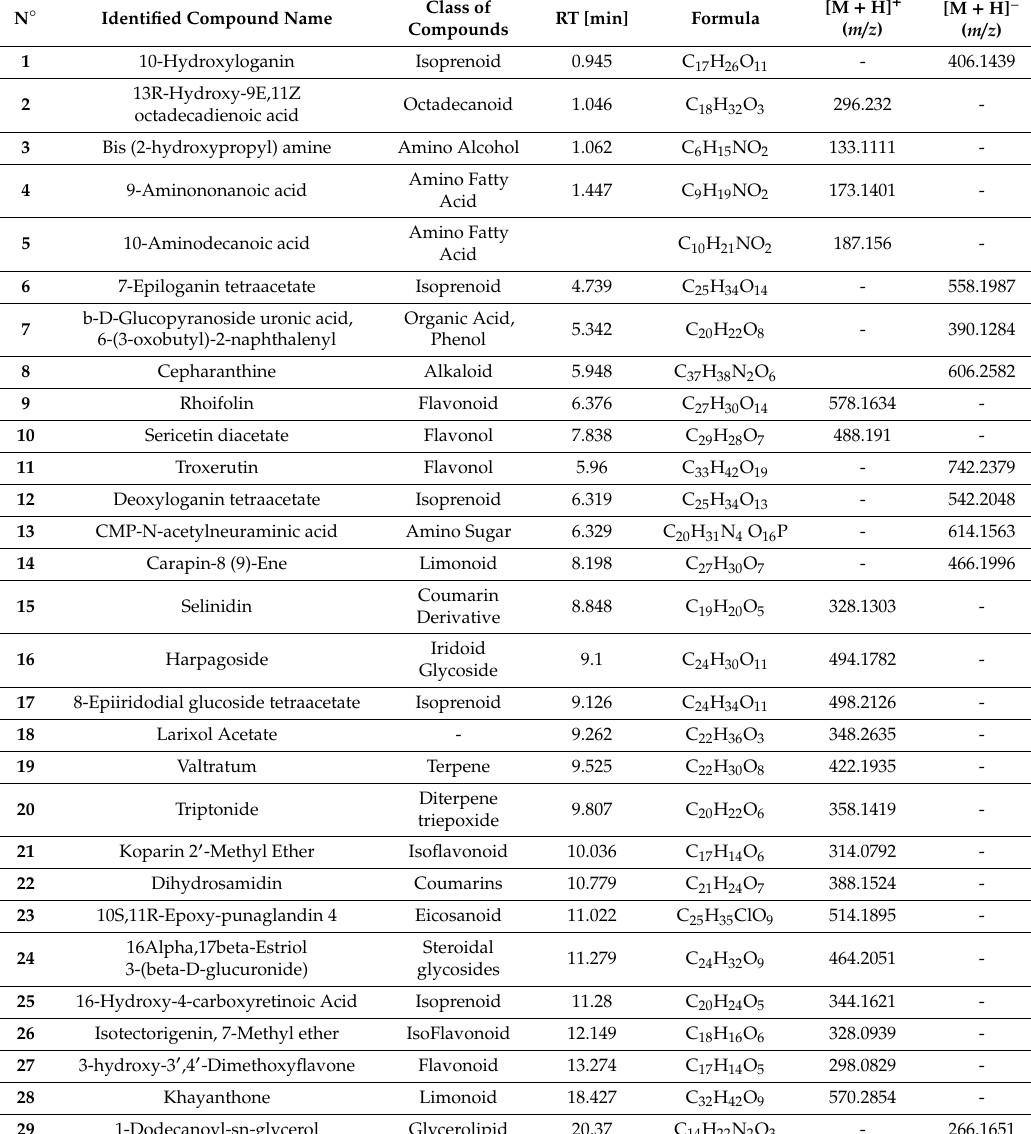
Table 2. Phytochemical composition of T. polium methanolic extract using the HR-LCMS technique. N